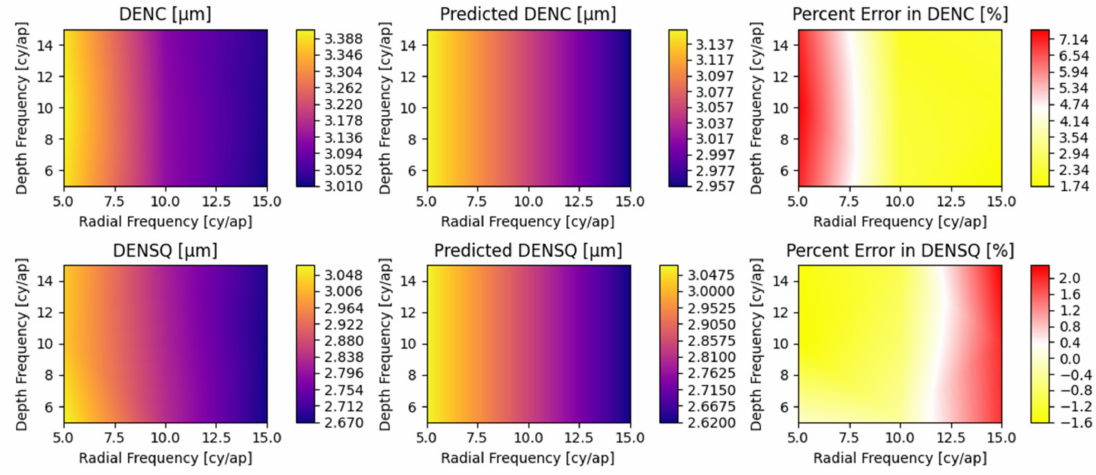
Figure A6. Radial Frequency versus depth frequency. (3 × 3 sampling matrix) ( κ = ω = δ = 0, η = 0.15, σ = 0.05, θ = 15 ◦ ).